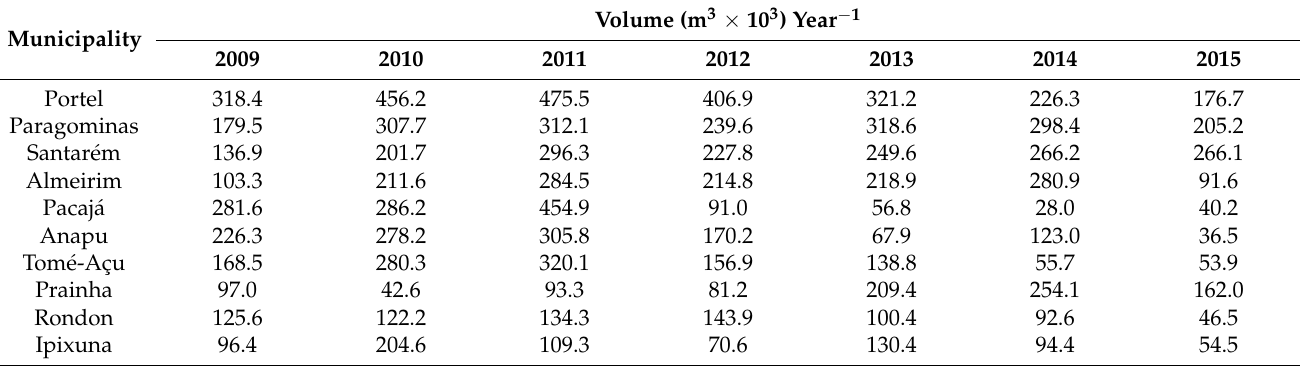
Table 2. Volume of log (1000 m 3 ) marketed in the ten most productive municipalities—SISFLORA-PA.